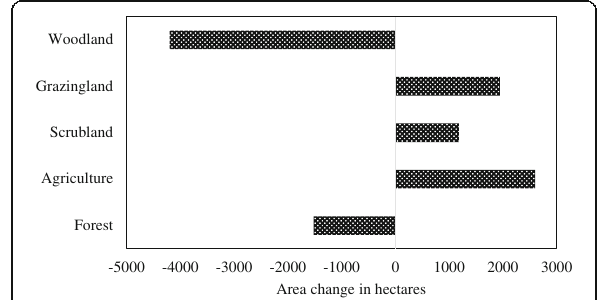
Fig. 6 Simulated landscape change from base year 2016 to 2046